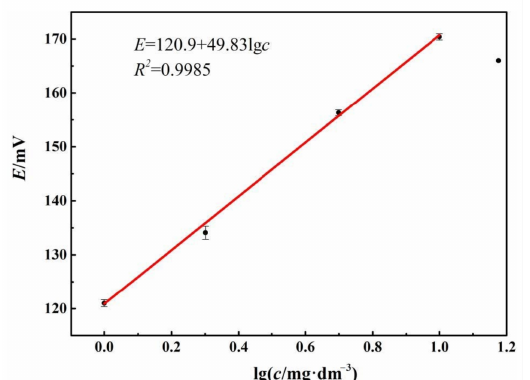
Figure 8. The linear relationship between OCP ( E ) and logarithm of TRC (lg c ) of the Fc-CPE electrode in 3.5 wt.% NaCl solution after 5-month